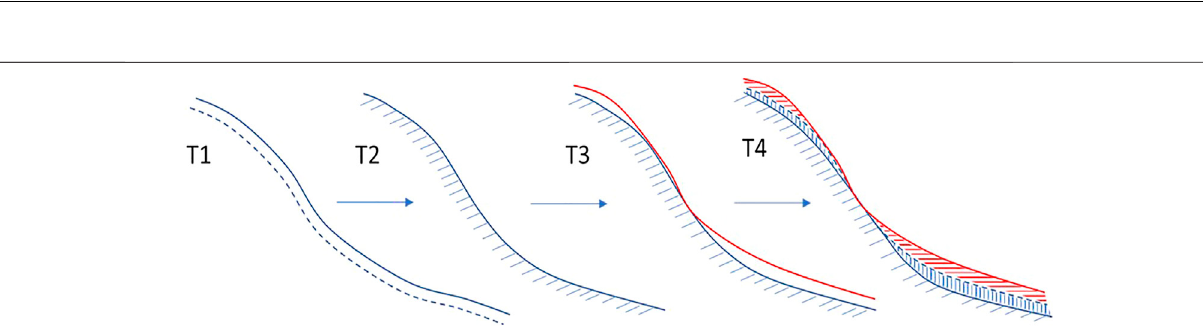
FIGURE 6 | Channel delineations for the WC. (A) WCW and (B) WCE. TLS coverage for the WC. (C) WCW and (D) WCE. Bedrock baseline coverage for the in- channel stored debris volume estimates. (E) WCW and (F) WCE.